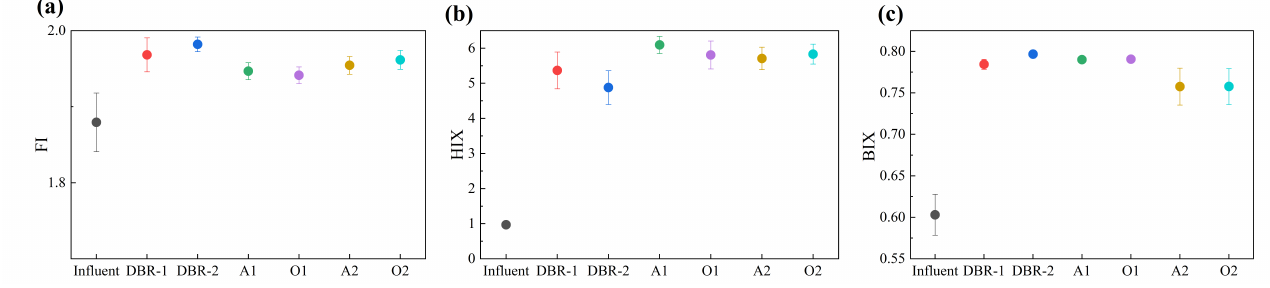
Figure 5. Variation diagram of fluorescence spectral indexes: ( a ) FI; ( b ) HIX; and ( c )